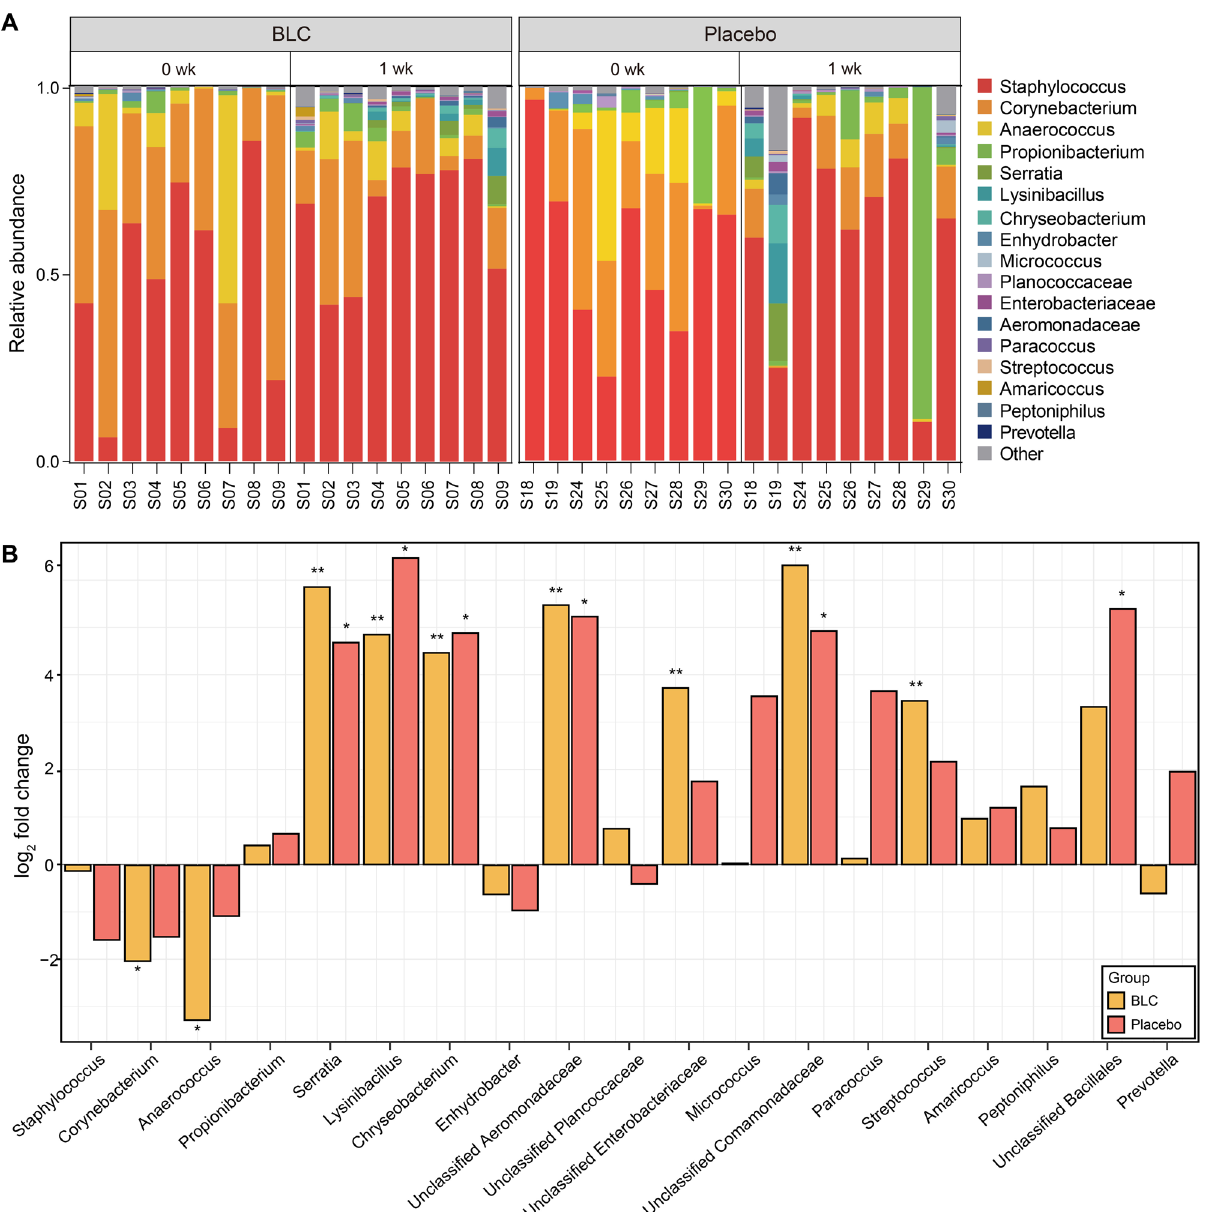
Figure 3. Taxonomic changes in the axillary microbiome for bioconverted product (BLC) and placebo. ( A ) The relative abundance of the axillary microbiome at the genus level. ( B ) Log2-fold-change in the BLC (yellow) and placebo (red), which represents changes at 1 week after using applications in comparison with those of the baseline samples. False discover rate-adjusted values < 0.05 and 0.01 are indicated with asterisks (* and **,